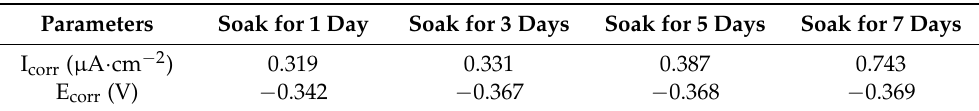
Figure 13. Nyquist and Bode plots of 3D-printed + modified samples immersed in simulated sea- water for different times. Figure 14 is the Tafel curve of 3D-printed + corroded samples immersed in simu- lated seawater for different times. From the figure, it can be seen that as the immersion time increases, the polarization curve gradually shifts to the left and the corrosion po- tential gradually decreases. Specific values can refer to Table 4; when the immersion time reaches 5 days, the corrosion potential drops to − 0.388 V, which is lower than that of the polished surface ( − 0.383 V, see Table 1), and the corrosion current density increas- es to 3.254 μ A·cm − 2 , which is higher than the polished surface (2.834 μ A·cm − 2 , see Table 1), so the corrosion resistance of the 3D-printed + corroded sample after being immersed